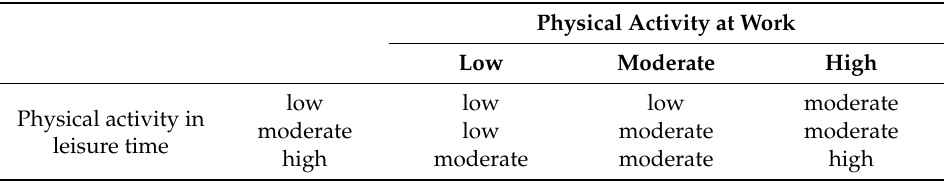
Table 6. Estimate the overall physical activity after combining data based on self-reported physical activity at work and physical activity in leisure time